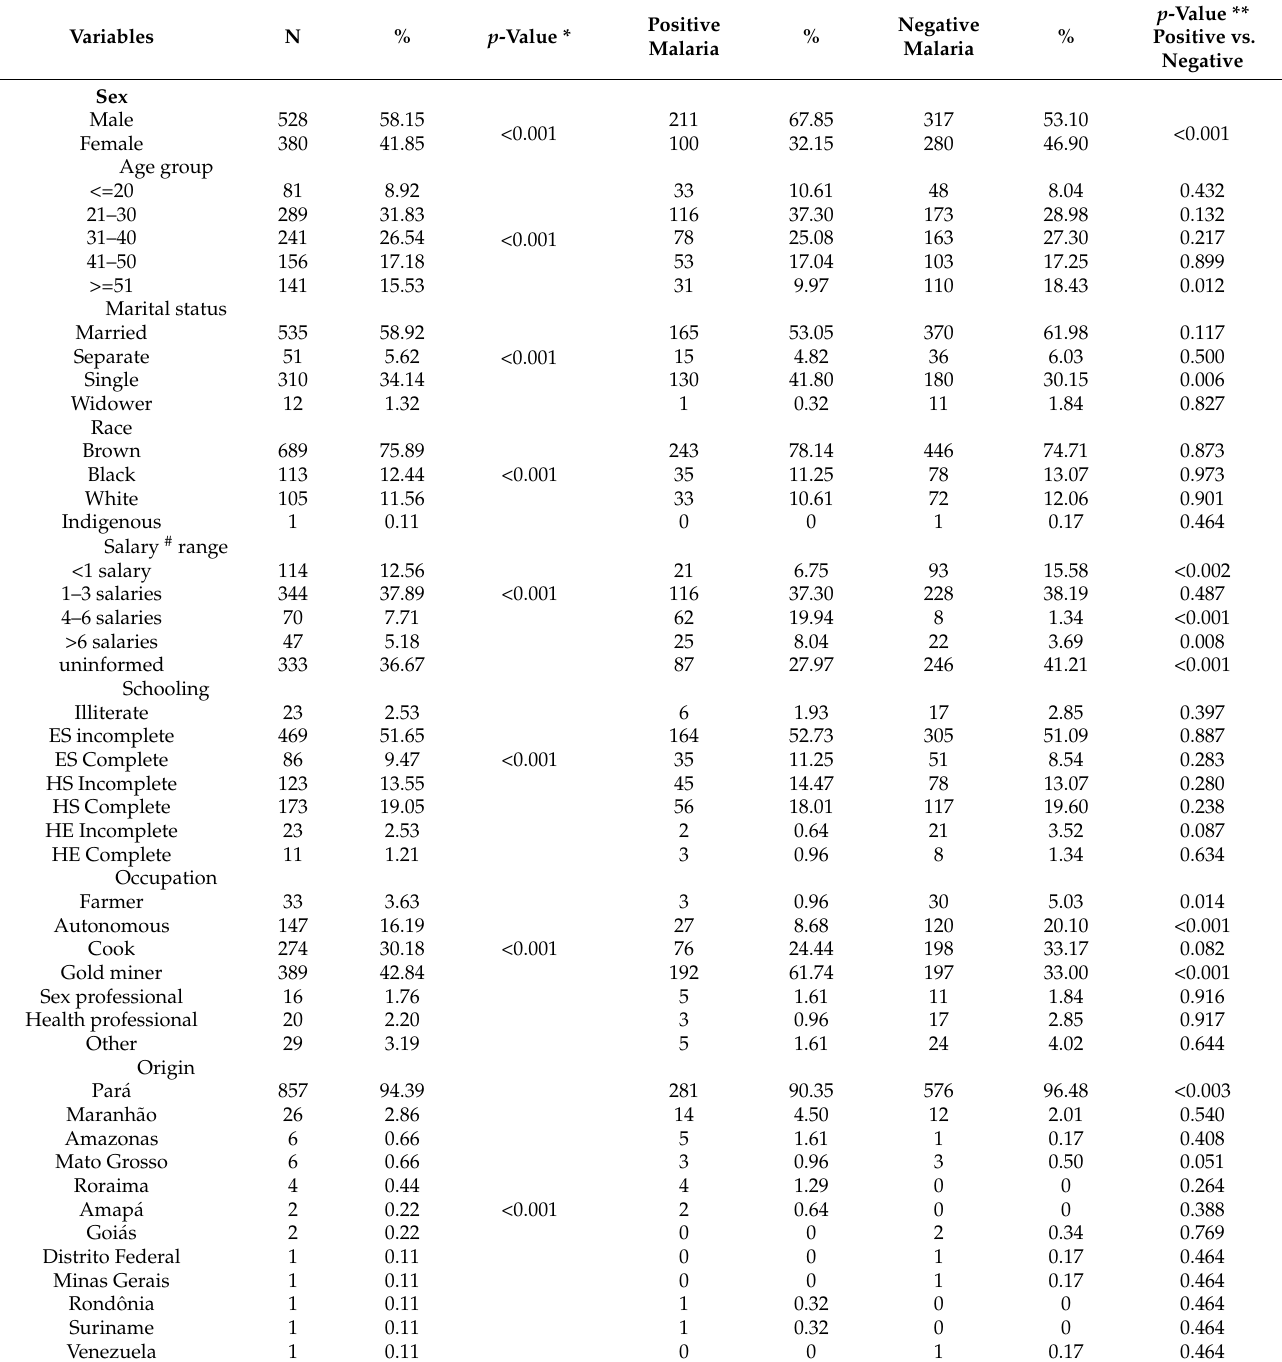
Table 1. Socio-demographic characteristics of individuals from Itatituba city, Par á state, Brazilian Amazon.